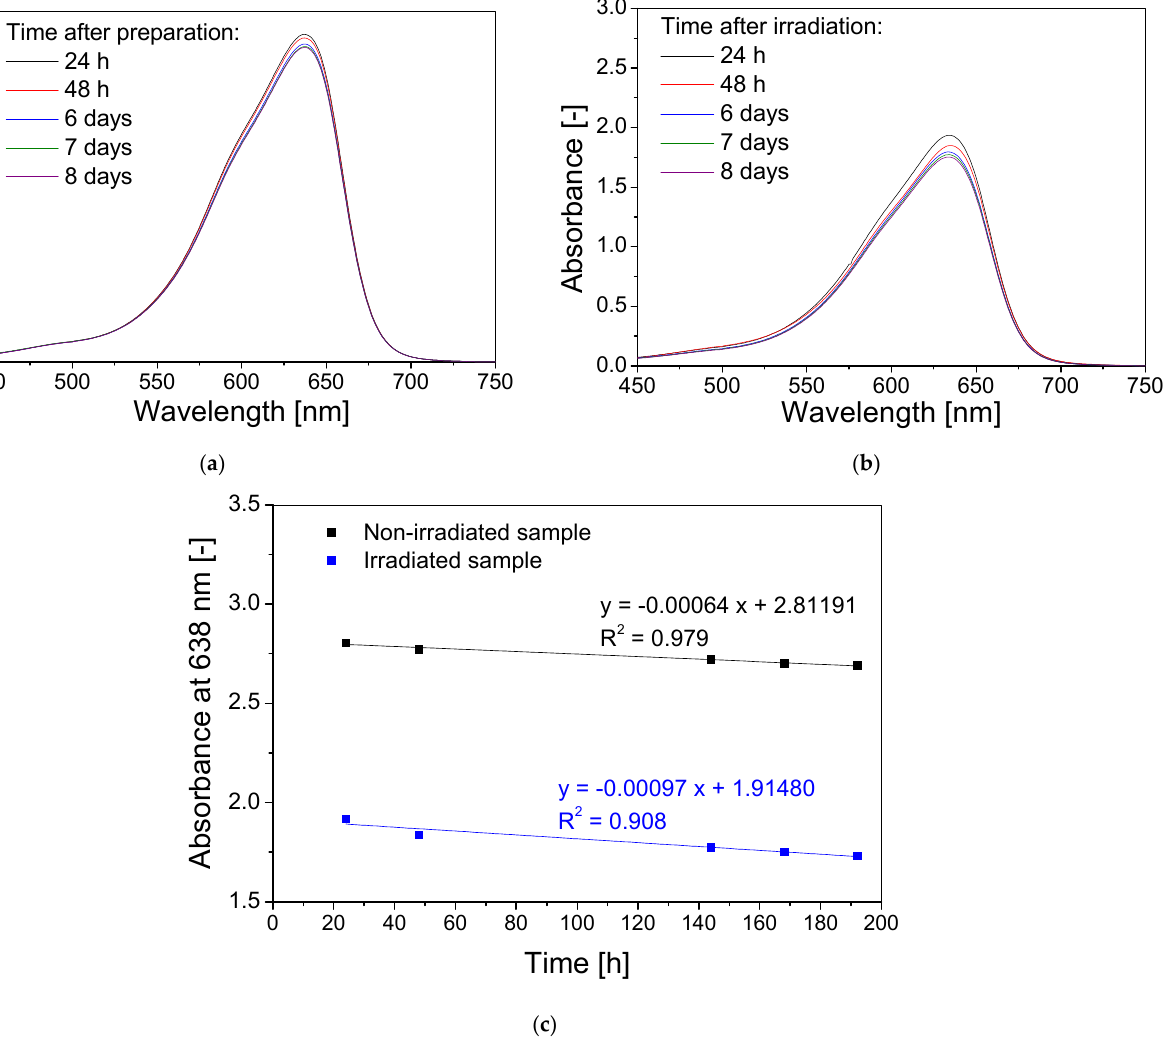
Figure 6. The stability of the gel ‐ hydrogel solution (60 μ M TBO, 5% H 2 O 2 , 25% Pluronic F–127) kept in a fridge. The samples were irradiated with 0.7 J/cm2 of UVB radiation and measured 1, 48 and 168 h after gel ‐ hydrogel preparation.